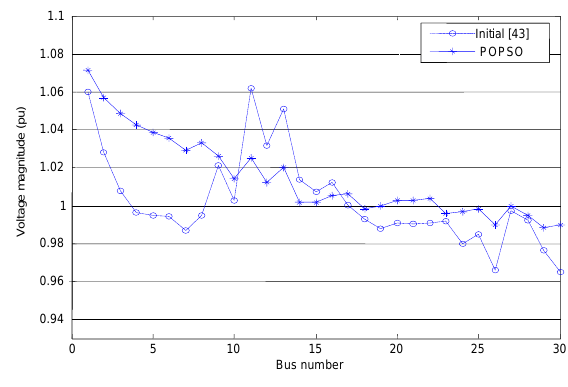
Figure 8. Bus voltage